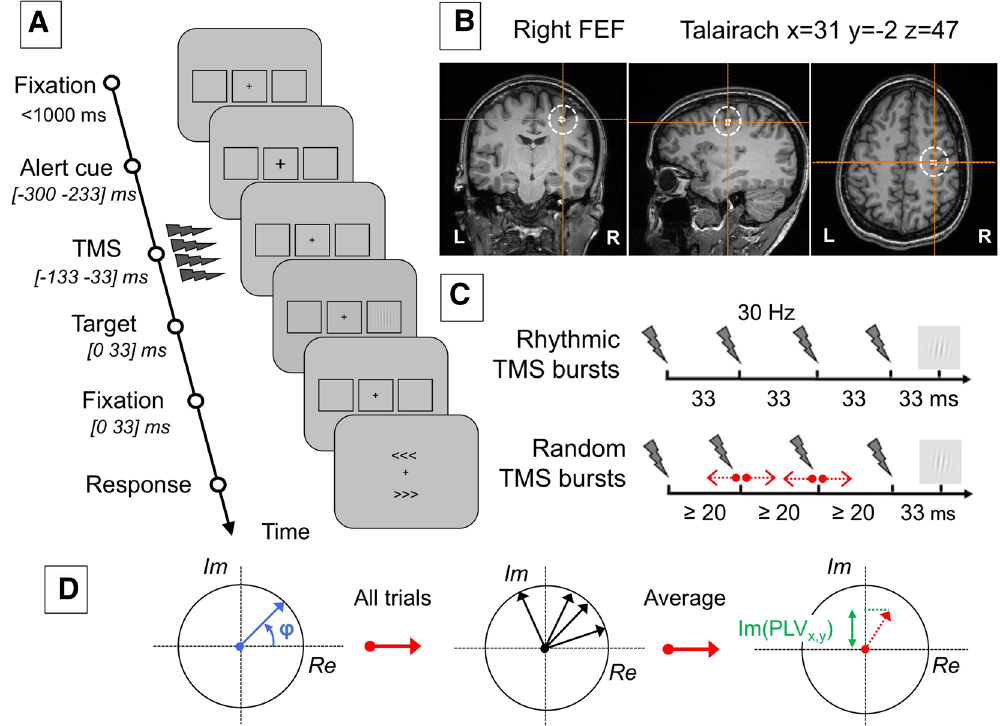
Figure 1. Experimental design, targeted cortical regions, TMS stimulation patterns and EEG phase synchrony measures. ( A ) Computer-based visual detection task performed by participants. After a period of fixation, a central cross became slightly larger to alert participants of an upcoming event; then active and sham rhythmic or random TMS patterns were delivered to the right FEF region prior to the presentation of a target that could appear at the center of a right or left placeholder for a brief period of time. Participants were requested to indicate whether they did perceive a target or not and, if they saw it, where it appeared (right/left). Notice that in 20% of the trials, no target was presented in any of the placeholders. ( B ) Coronal, mid-sagittal and axial MRI sections from the frameless stereotaxic neuronavigation system showing the localization of the targeted cortical right FEF (Talairach coordinates x = 31, y = − 2, z = 47) in a T1-3D MRI of a representative participant. ( C ) Schematic representation of the active and sham 4 pulse TMS patterns employed: 30 Hz rhythmic stimulation to entrain oscillatory activity at the input frequency (~33 ms interpulse interval) in the right FEF, and the random stimulation (jittered interpulse intervals) used as a control to isolate the effect of stimulation frequency. ( D ) Schematic representation of phase locking value calculations to estimate changes in interregional synchronization. The phase of signals between two sets of electrodes was extracted from the Fourier spectra. For all trials, complex vectors were reconstructed with a phase (φ) equal to the phase difference between the two signals. These complex vectors were averaged over trials. TMS volume conduction was ruled out by calculating the imaginary phase locking value (imaginary PLV or imPLV), which consisted in the projection on the imaginary axis of the complex vector averaged over all